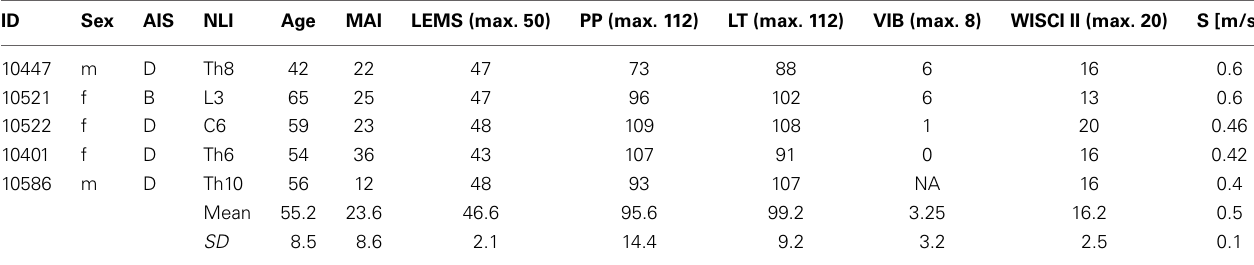
Table 2 | Characteristics of individuals with SCI included in the feasibility study.